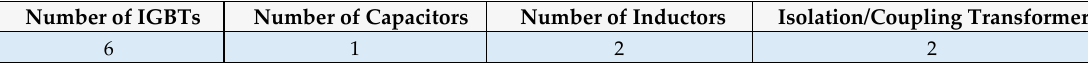
Figure 8. RPC based on two-phase three-wire converter (TW-RPC) with coupling transformers (based on [27]). Table 6. Components quantities of the TW-RPC.